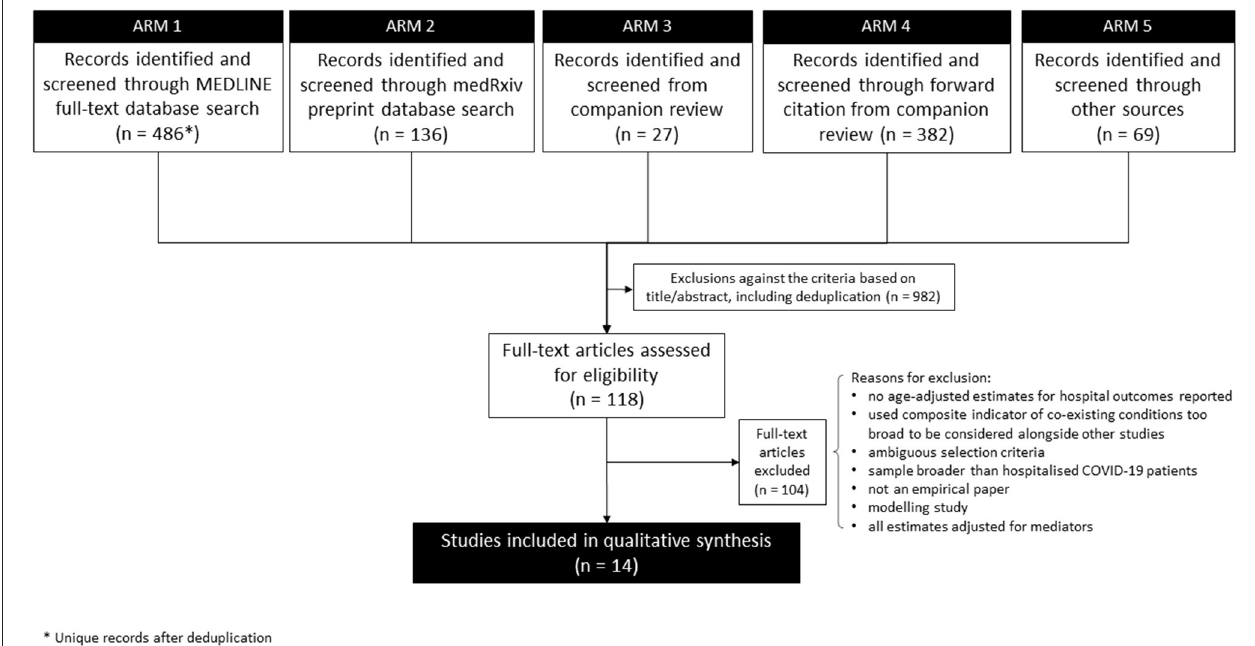
FIGURE 1 | Flowchart of progression of studies through the review of age-adjusted associations between comorbidity and outcomes of COVID-19 in the early stages of the